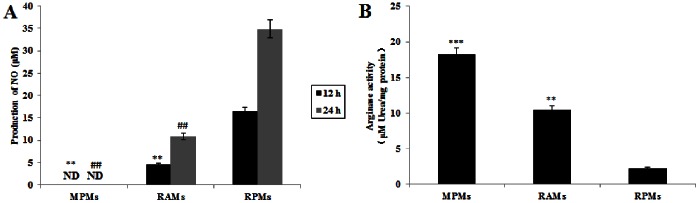
Comparison of nitric oxide production and arginase activity among RAMs, MPMs and RPMs.(A) A comparison of NO production between different macrophage types as measured by the Griess reaction, relative to RPMs. Data represent mean ± SEM calculated from 3 independent experiments performed in triplicate. Probabilities **p<0.01, (ANOVA), show significant differences from NO production of RPMs cultured for 12 hrs; probabilities ##
p<0.01, (ANOVA), show significant differences from NO production of RPMs cultured for 24 hrs. (B) A comparison of arginase activity, as measured by a colorimetric assay (enzyme activity is the output of urea secreted from lysed macrophages), between different macrophage types relative to RPMs. Data represent a mean ± SEM calculated from 3 independent experiments performed in triplicate. Probabilities **p<0.01 and ***p<0.001, (ANOVA), show significant differences from arginase activity of freshly purified RPMs.